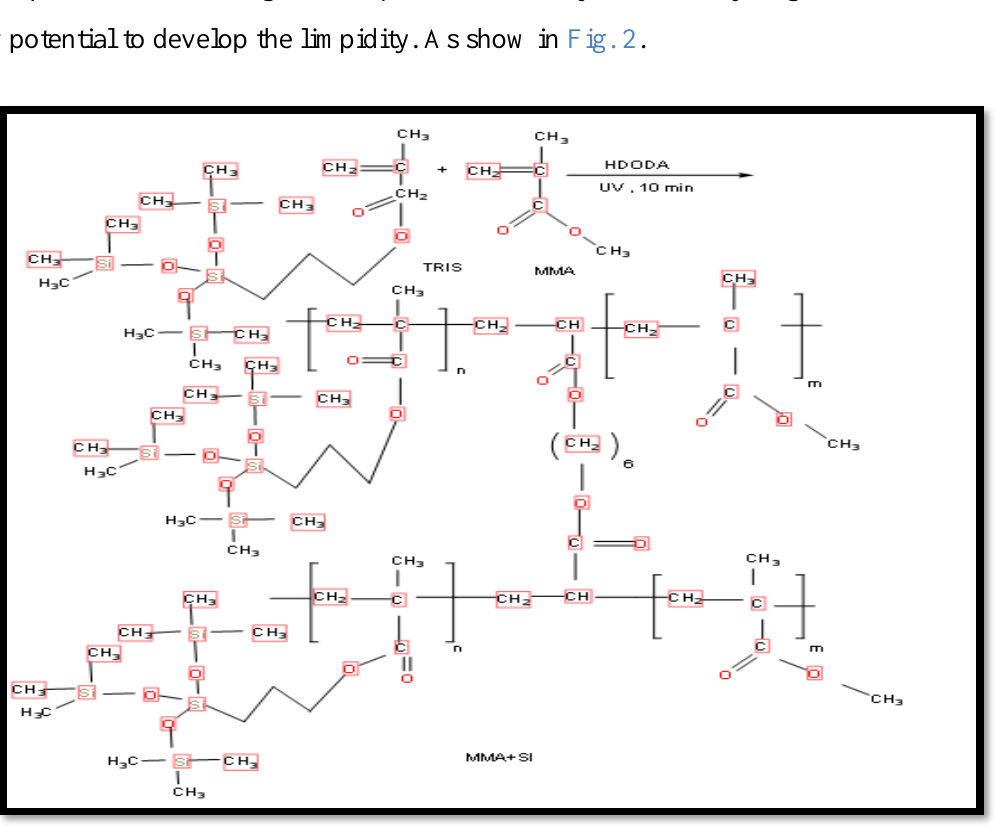
Fig. 2. Copolymerization and Crosslinking of HDODA with